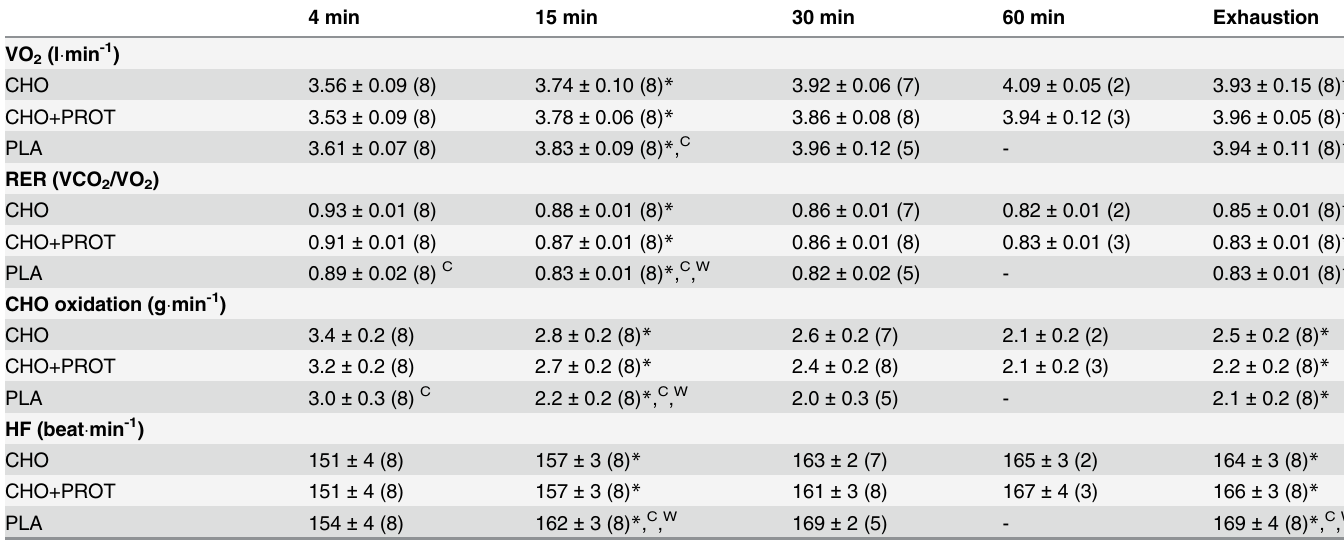
Table 3. VO 2 , RER, CHO oxidation and HF during the performance test (TTE) after the three diet interventions (Day